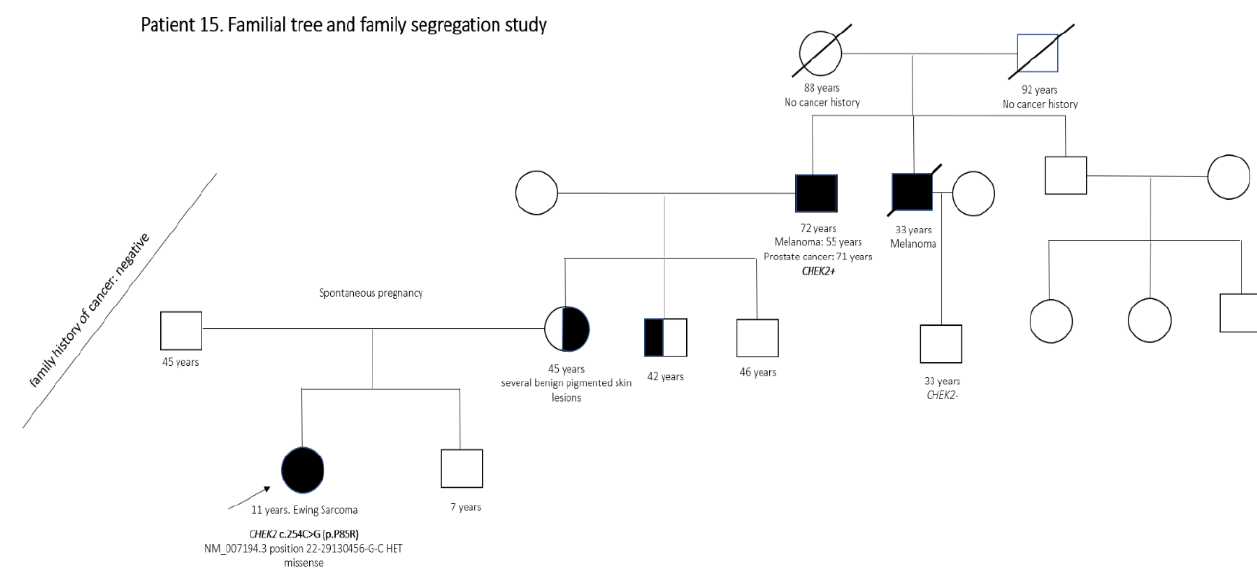
Figure 4. Family tree of patient number 15. Despite not fulfilling the Jongmans MC criteria nor the revised criteria by Ripperger, the patient’s family history of cancer was still suggestive for genetic cancer predisposition and the genetic counseling was advised based on this information. The adolescent was diagnosed with extraosseous Ewing sarcoma. A CHEK2 variant was detected by the NGS OncoNano V2 panel. The variant was described in the general population (gnomAD reports three total heterozygotes). However, it was described six times in ClinVar and three times in cancer patients (uncertain clinical significance (ID 233261)). It was not found in other databases. In addition, it is a variant studied functionally on one occasion. It was reported in the literature in a patient with hereditary breast cancer, with functional in vitro study that demonstrated a 50% reduction in kinase activity [45], although the location of the variant was outside of a functional domain. The variant was found to be of maternal origin and family history of melanoma was identified in the grandfather and great-uncle in this branch of the family. In addition, the grandfather had had a second tumor at an older age. Based on the ACGM criteria and family information, the variant was classified as likely pathogenic.